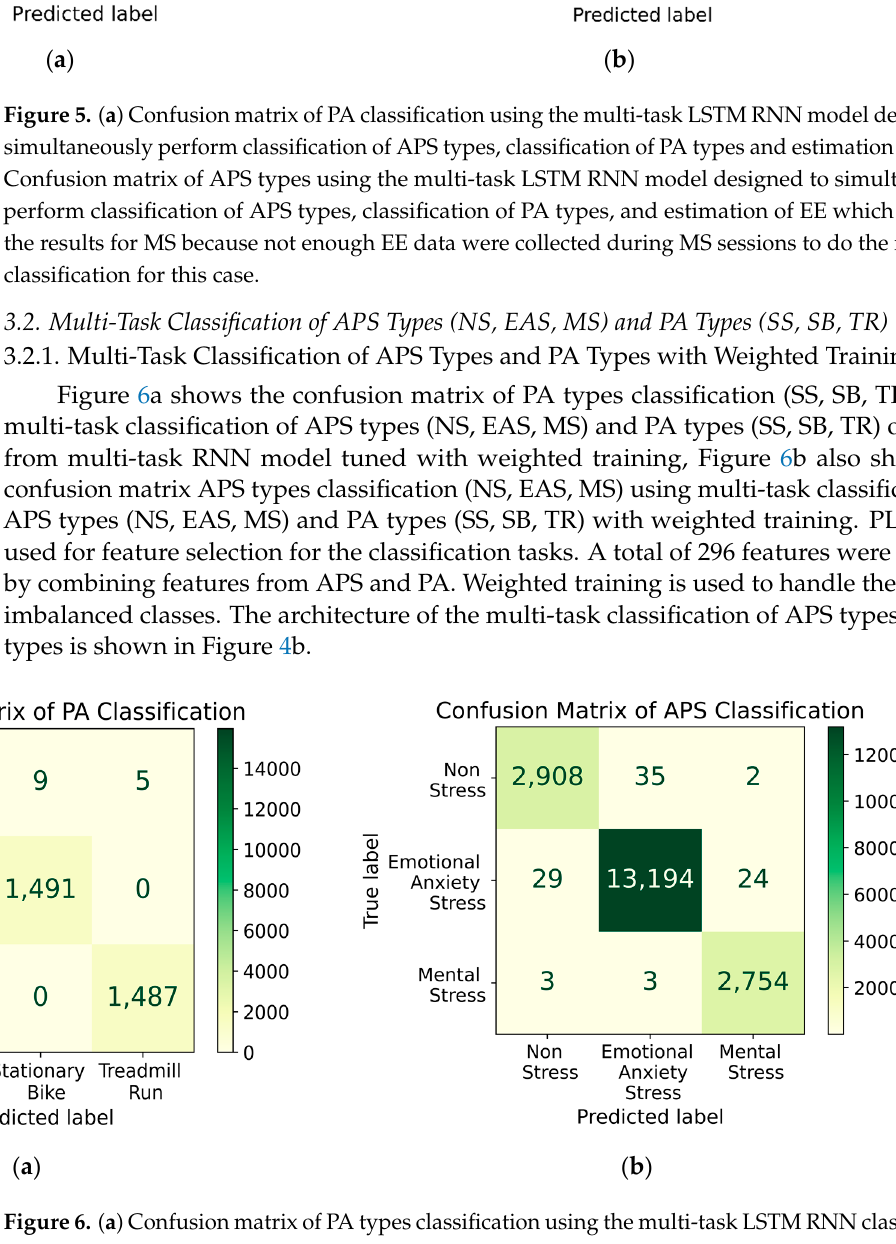
the results for MS because not enough EE data were collected during MS sessions to do the multitask the multitask classification for this case.